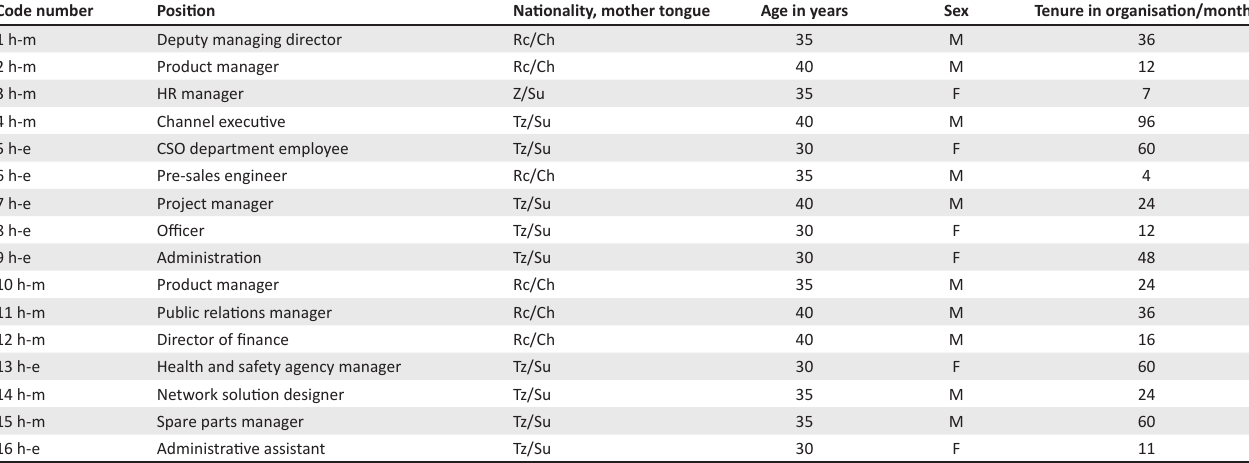
TABLE 1: Biographical data. Code number